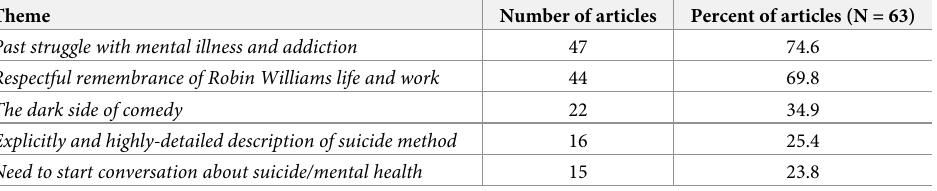
Table 4. Themes emerging from the inductive